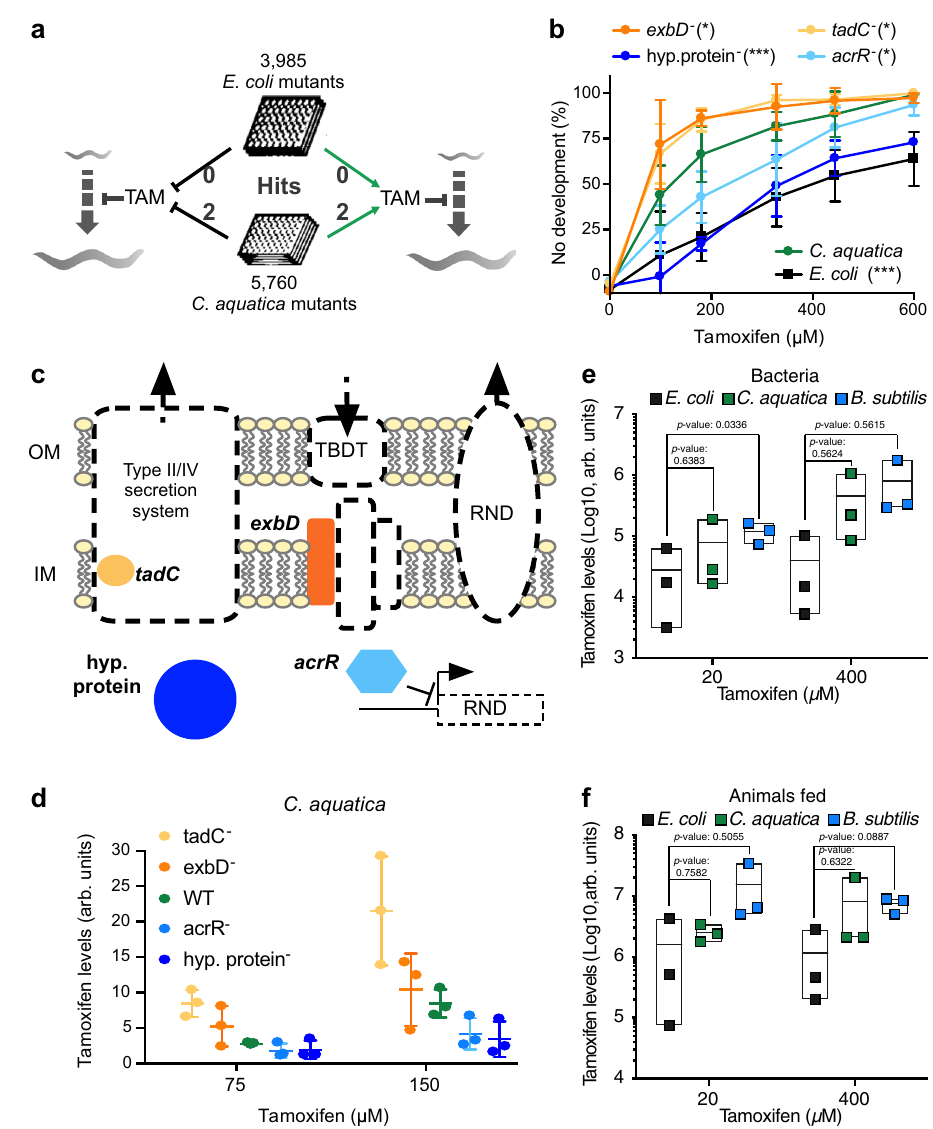
Fig. 2 | C. aquatica transporter mutants modulate tamoxifen toxicity in C. elegans . a Schematic of the bacterial genetics screens was performed. b DRCs of tamoxifen toxicity in animals fed C. aquatica mutants identi fi ed in the primary screen. Data were represented as mean±SEM of three independent biological replicates. Statistical analysis of DRCs was conducted by performing two-way ANOVA followed by a Dunnett multi-comparison test using the wild-type E. coli condition asa control onGraphPadPrism (v9).Adjusted p values <0.0001 ( E. coli ), 0.0415 ( tadC − ), 0.0169 ( acrR − ) , 0.0456 ( exbD − ), <0.0001 (hypothetical protein -